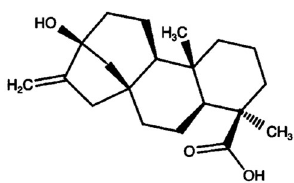
Figure 1. Structure of the main steviol glycosides in S. rebaudiana.